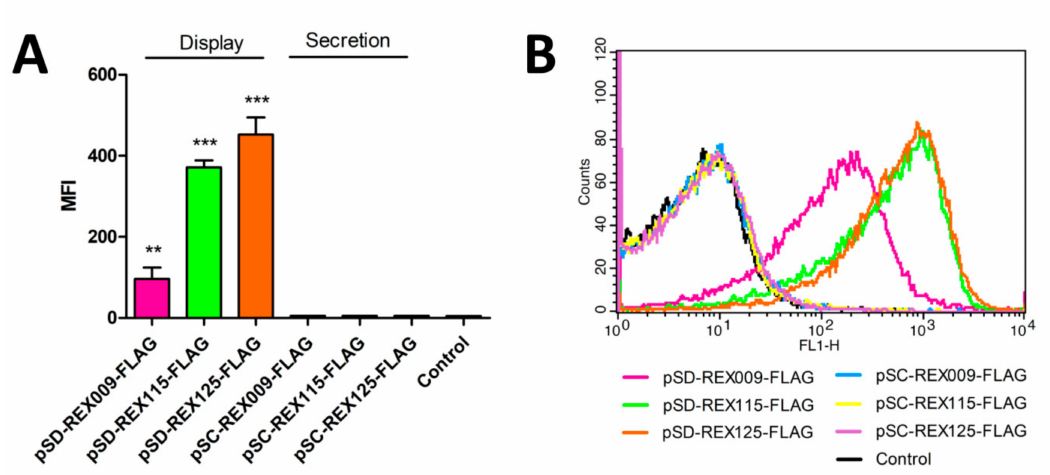
Figure 4. Flow cytometry of L. lactis cells displaying or secreting FLAG-tagged REX variants, detected with an anti-FLAG antibody. Control: L. lactis containing an empty plasmid of pNZ8148. ( A ) Mean fluorescence intensity (MFI) or ( B ) the shift in fluorescence intensity of representative measurements are depicted. Error bars denote standard deviations. Significant di ff erences (** p < 0.005, *** p < 0.001; Student’s t -test) are marked with an asterisk.